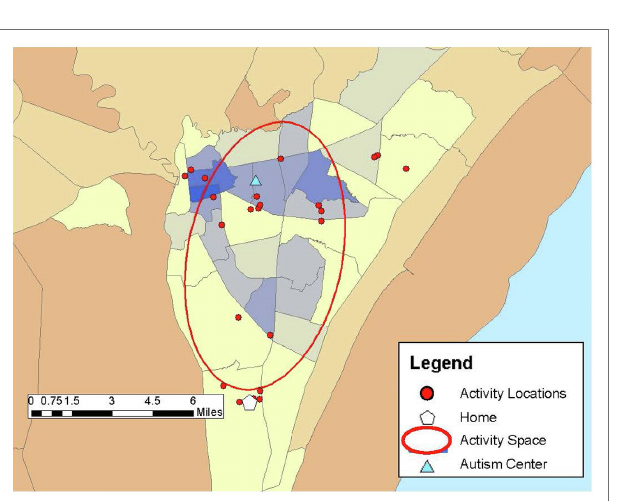
FIGURE 4 | Pete’s community locations and activity space (8.6 mi 2 ) from the GPS study week reflect his visits to several locations close to home and the autism center he volunteered with during the 1-week study period.